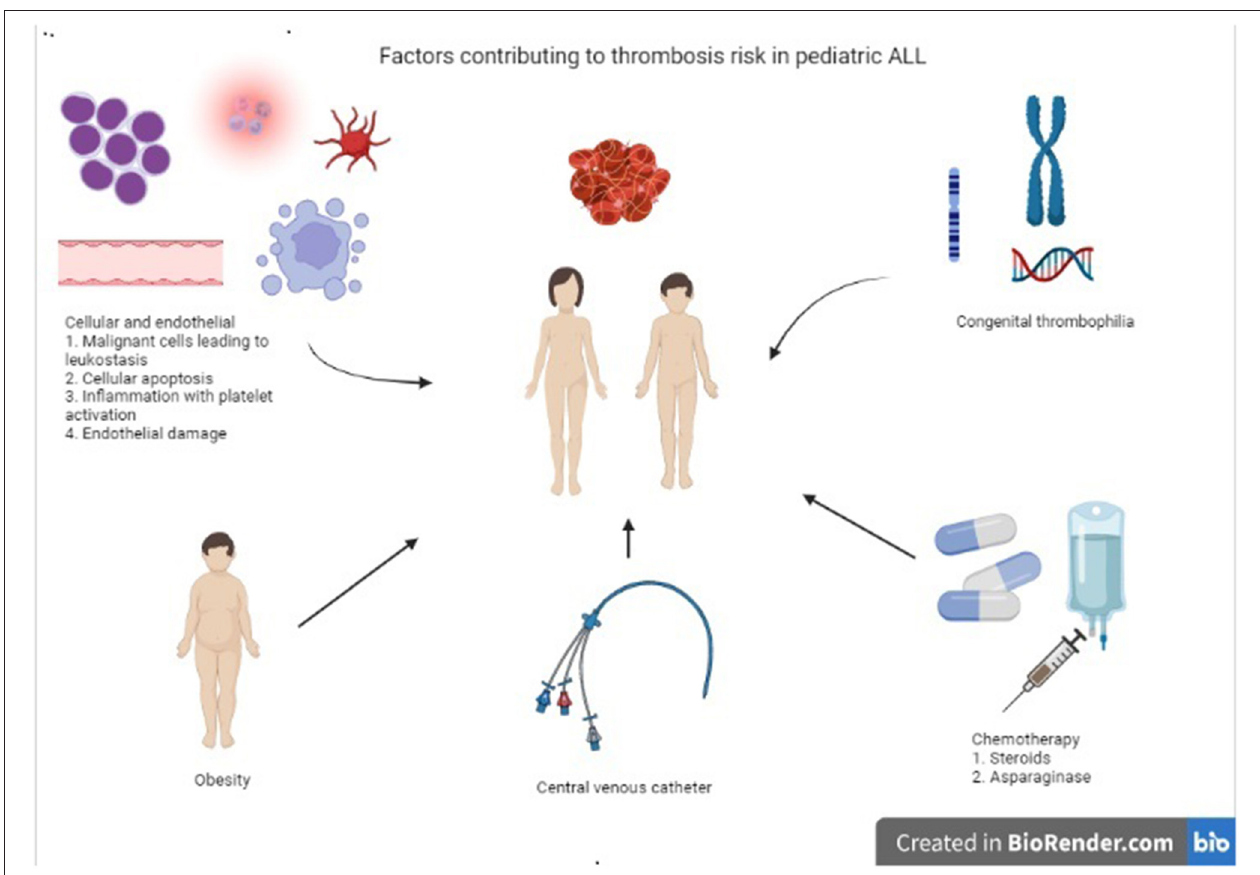
FIGURE 1 | Summary most common risk factors contributing to thrombosis risk in children, adolescents, and young adults with